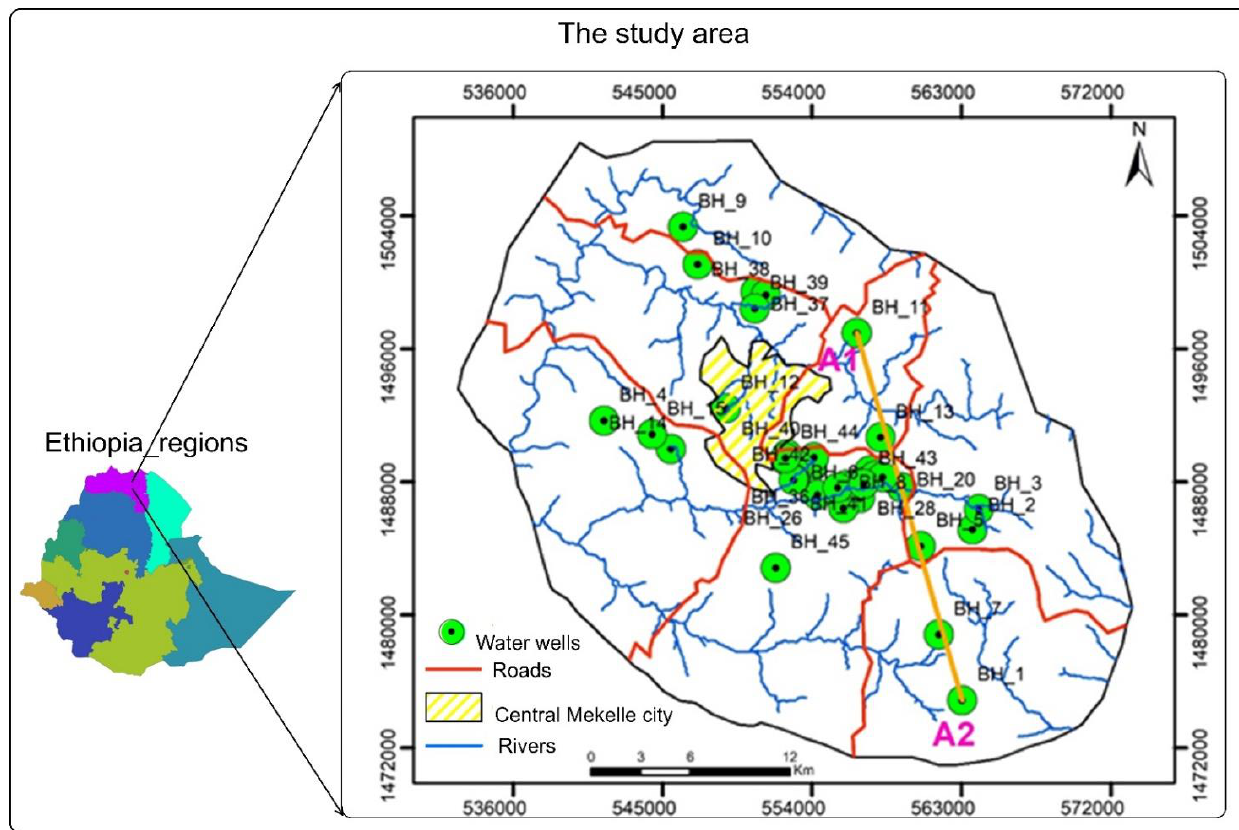
Figure 1. Location map of the study area.